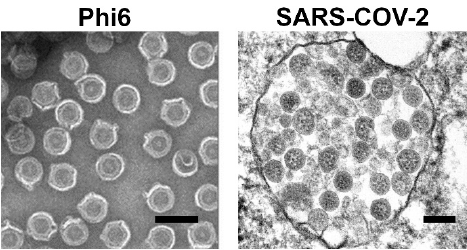
Figure 1. The comparison of enveloped phage Phi6 [65] and SARS ‐ CoV ‐ 2 virus [66] using scanning electron microscopy imaging. The scale bar is 100 nm. Phi6 image was adapted from Block et al., based on CC BY 4.0 License [65]. SARS ‐ CoV ‐ 2 image was adapted from Goldsmith et al. [66] based on Elsevier License No. 5375361146341. The major drawback of using phages as antimicrobials is the stability of virions. The primary criteria are virulence, selectivity, host range, ease of manipulation, and modifi ‐ cation. Even though phages are capable of retaining their activity after exposure to stress factors (including high temperatures [67], pH [68], and organic solvents [69,70]), this re ‐ sistance is only an additional factor in the search for valuable medical purposes. Stabil ‐ ity ‐ determining factors were described in the review by Jo ń czyk ‐ Matysiak et al. [71]. The authors focused on the effects of chemicals and physical factors, including pH, tempera ‐ ture change (freezing, heat), and UV ‐ light. The matter of phage suspension stability is not to be underestimated. Improper preparation of such suspension can affect the effectiveness of the phage therapy ap ‐ proach. For instance, in the Phagoburn project, storing bacteriophages in unsuitable con ‐ ditions dramatically decreased phage titer a thousand ‐ fold within just fifteen days. Be ‐ cause of this, patients received lower dosages of phages (10 2 PFU/mL daily), about 5 log below the required rate of infection (ROI) [40]. With the shift in attention towards phage ‐ based pharmaceutics, the precise nature and uniformity of bacteriophages are gaining increased appreciation. The preliminary testing of phage therapy did not concern the stability of phages; however, commercial circulation would require stable concentrations and known dosages. Phages often lose activity during formulation and storage. The most common factors affecting the viability of phages (and phage proteins) include exposure to organic solvents, high temperatures, pH, and ionic strength [72]. 2. Polymer ‐ Based Stabilization A polymer is a substance or material of large molecular mass composed of repeat ‐ ing subunits ( Encyclopedia Britannica ). Because of a large number of subunits, removing one of them does not change the properties of the entire molecule. Polymers can be di ‐ vided into natural (proteins, nucleic acids, and polysaccharides) and synthetic (polyeth ‐ ylene, polytetrafluoroethylene, and polypropylene) [73]. Although polymers’ usage for phages and virus stabilization is in the early stages, some interesting applications have already been reported. The effect of sugars as stabilizers against protein unfolding is known [74–78]. Be ‐ cause of this effect, sucrose has been used as a cryo ‐ stabilizer for freeze ‐ dried vaccines. Yet, it has been shown that sucrose ‐ induced stabilization of the viral capsid proteins alone does not necessarily lead to virus capsid stabilization [74]. More importantly, the protein stabilization effect is broadly observed with many sugars [79–82], but only su ‐ crose and trehalose seem to be effective in stabilizing viral capsids [79,83]. Sucrose is known to enhance protein–protein binding at molar concentrations by modifying pro ‐ tein hydration properties [75], and thus, it is effective in the stabilization of vaccines [79,83–85]. Other carbohydrates, such as agar or alginate, can also be used for the stabili ‐